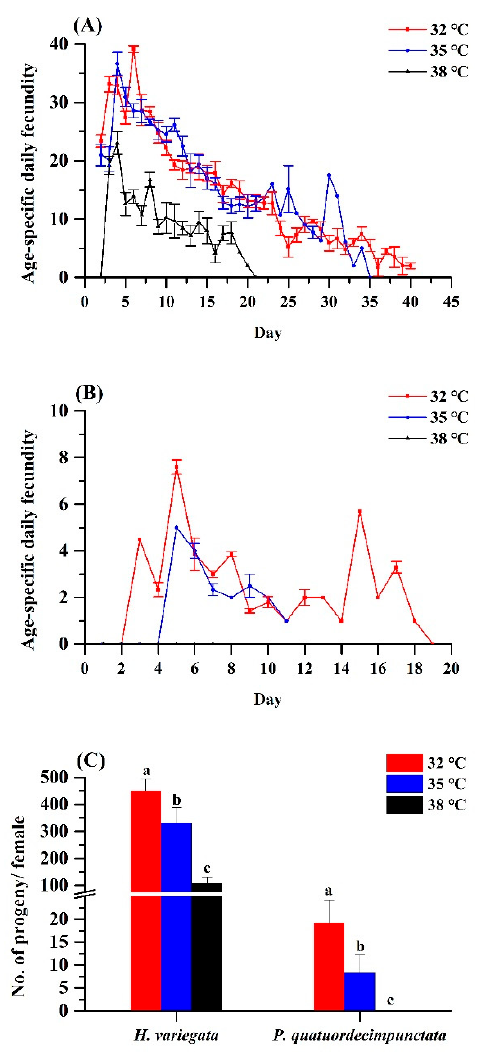
Figure 2. Age-specific fecundity of adult Hippodamia variegata ( A ) and Propylaea quatuordecimpunctata ( B ) at different temperatures. ( C ) Fecundity of both species. For each species, different letters above the bars indicate statistically significant differences among temperatures (ANOVA; Tukey’s post hoc test; p < 0.05).